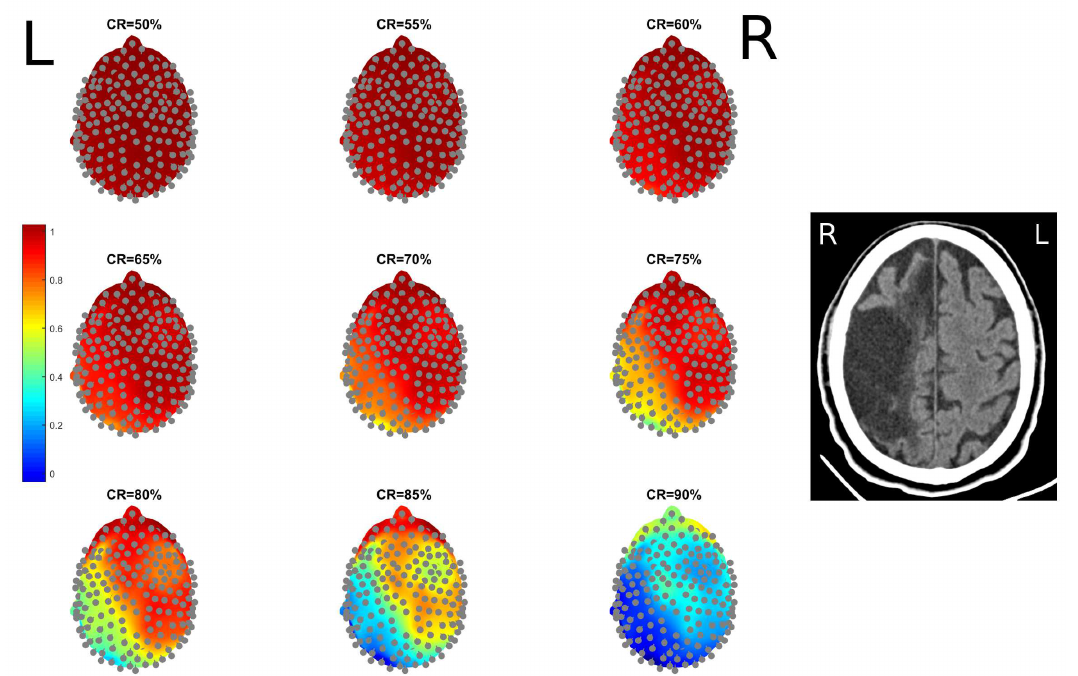
Figure 4. Topographical representation of the reconstruction quality of EEG signals, at increasing compression rates (CR). The SSIM values of Every EEG channels are depicted with a coloration ranging from blue (low SSIM) to red (high SSIM). Right ( R ) and Left ( L ) sides are indicated with black capital letters. The patient in this example is impaired in the right hemisphere and exhibits higher SSIM in the right hemisphere for every CR. The computed tomography (CT) image of the patient is shown on the right, Right ( R ) and Left ( L ) sides are indicated with white capital letters (note that Right and Left look reversed in CT